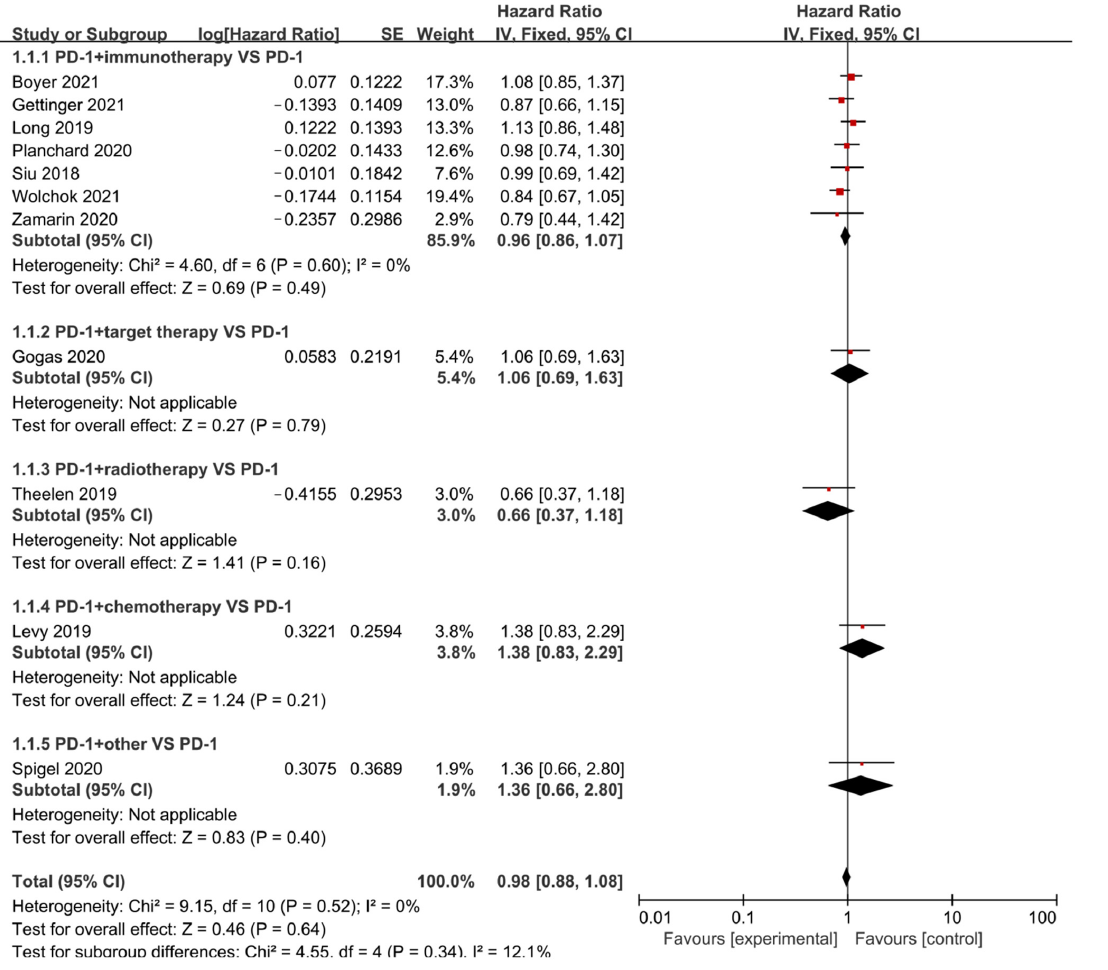
Figure 4. Forest Plot of the Hazard ratio of OS based on therapeutic schedules: anti-PD-1/PD-L1 versus combination therapy (immunotherapy, targeted therapy, radiotherapy, chemotherapy, and other drugs). Boyer 2021 [12] ,